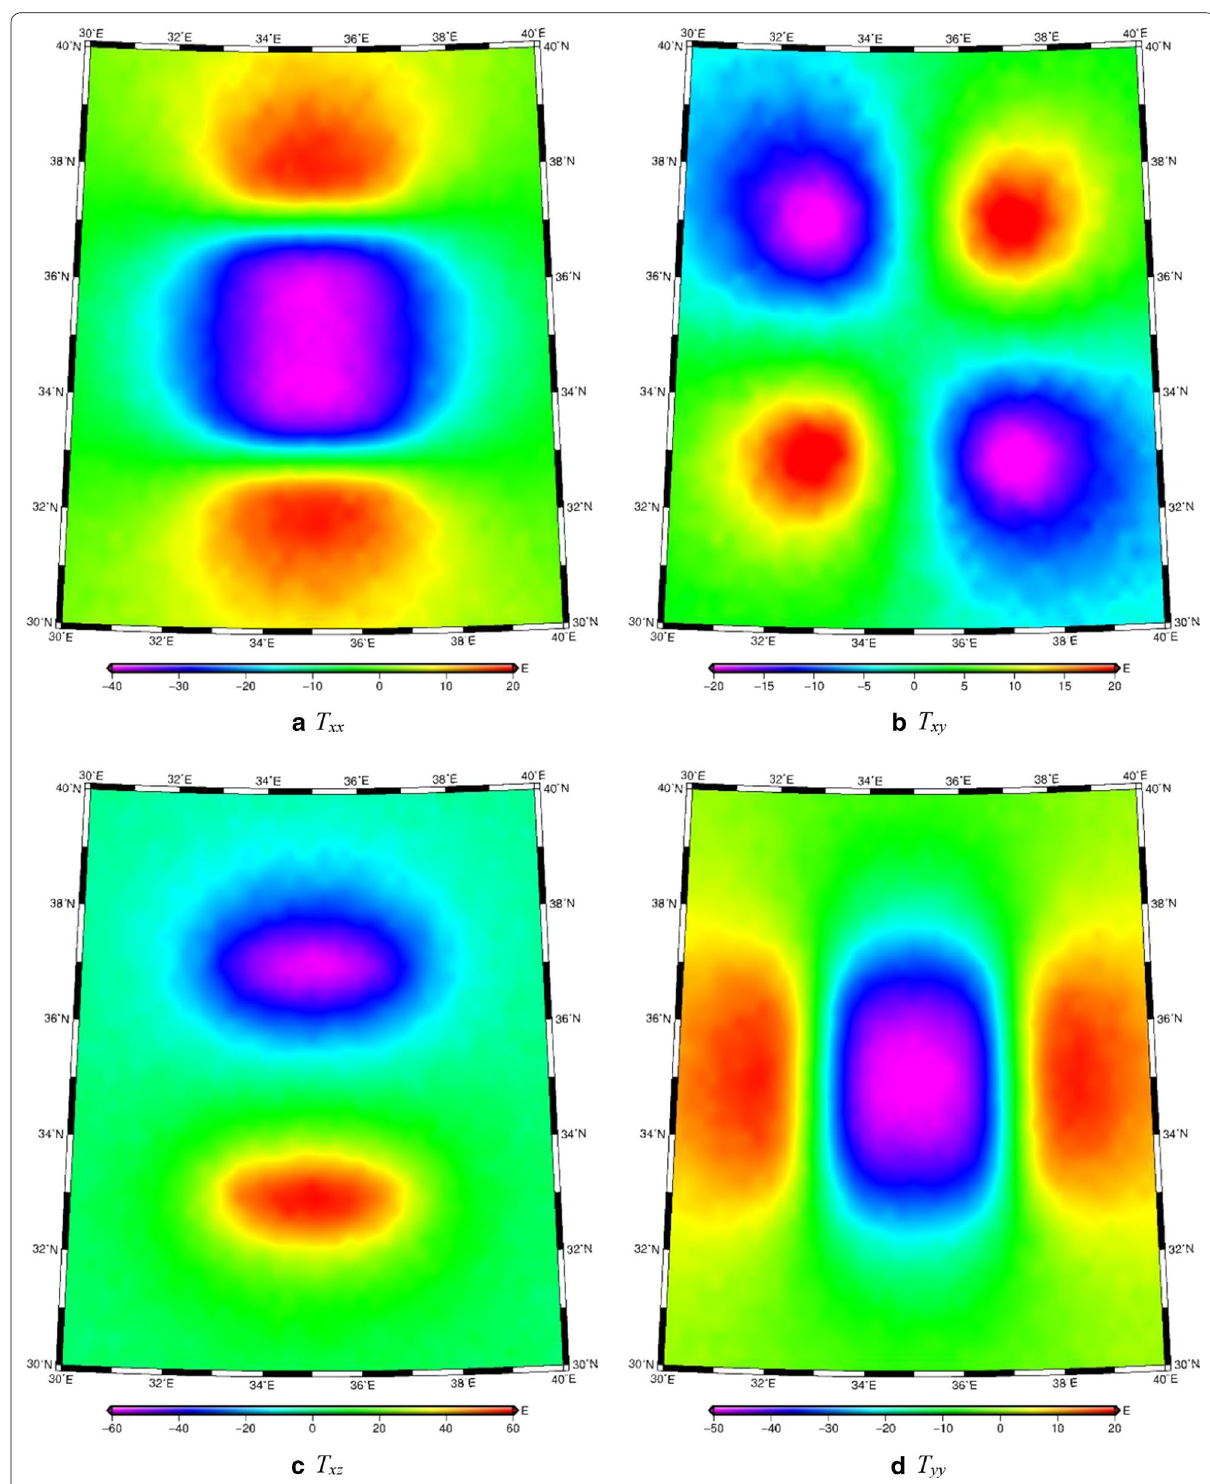
Fig. 5 Artificial theoretical datasets of the GGT with noise for single model, a , b , c and d are T xx , T xy , T xz and T yy component of the GGT,